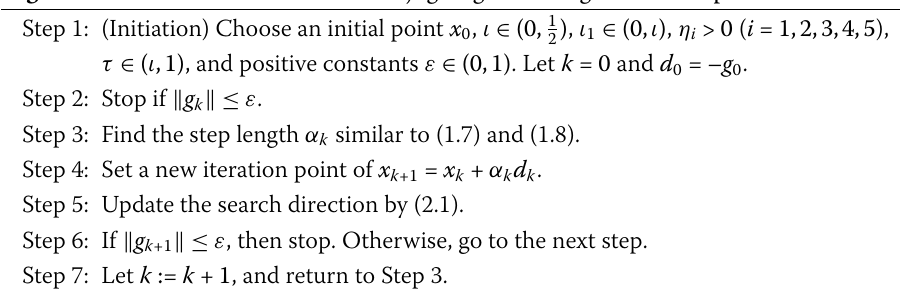
Algorithm 2.1 Modified three-term conjugate gradient algorithm for optimization